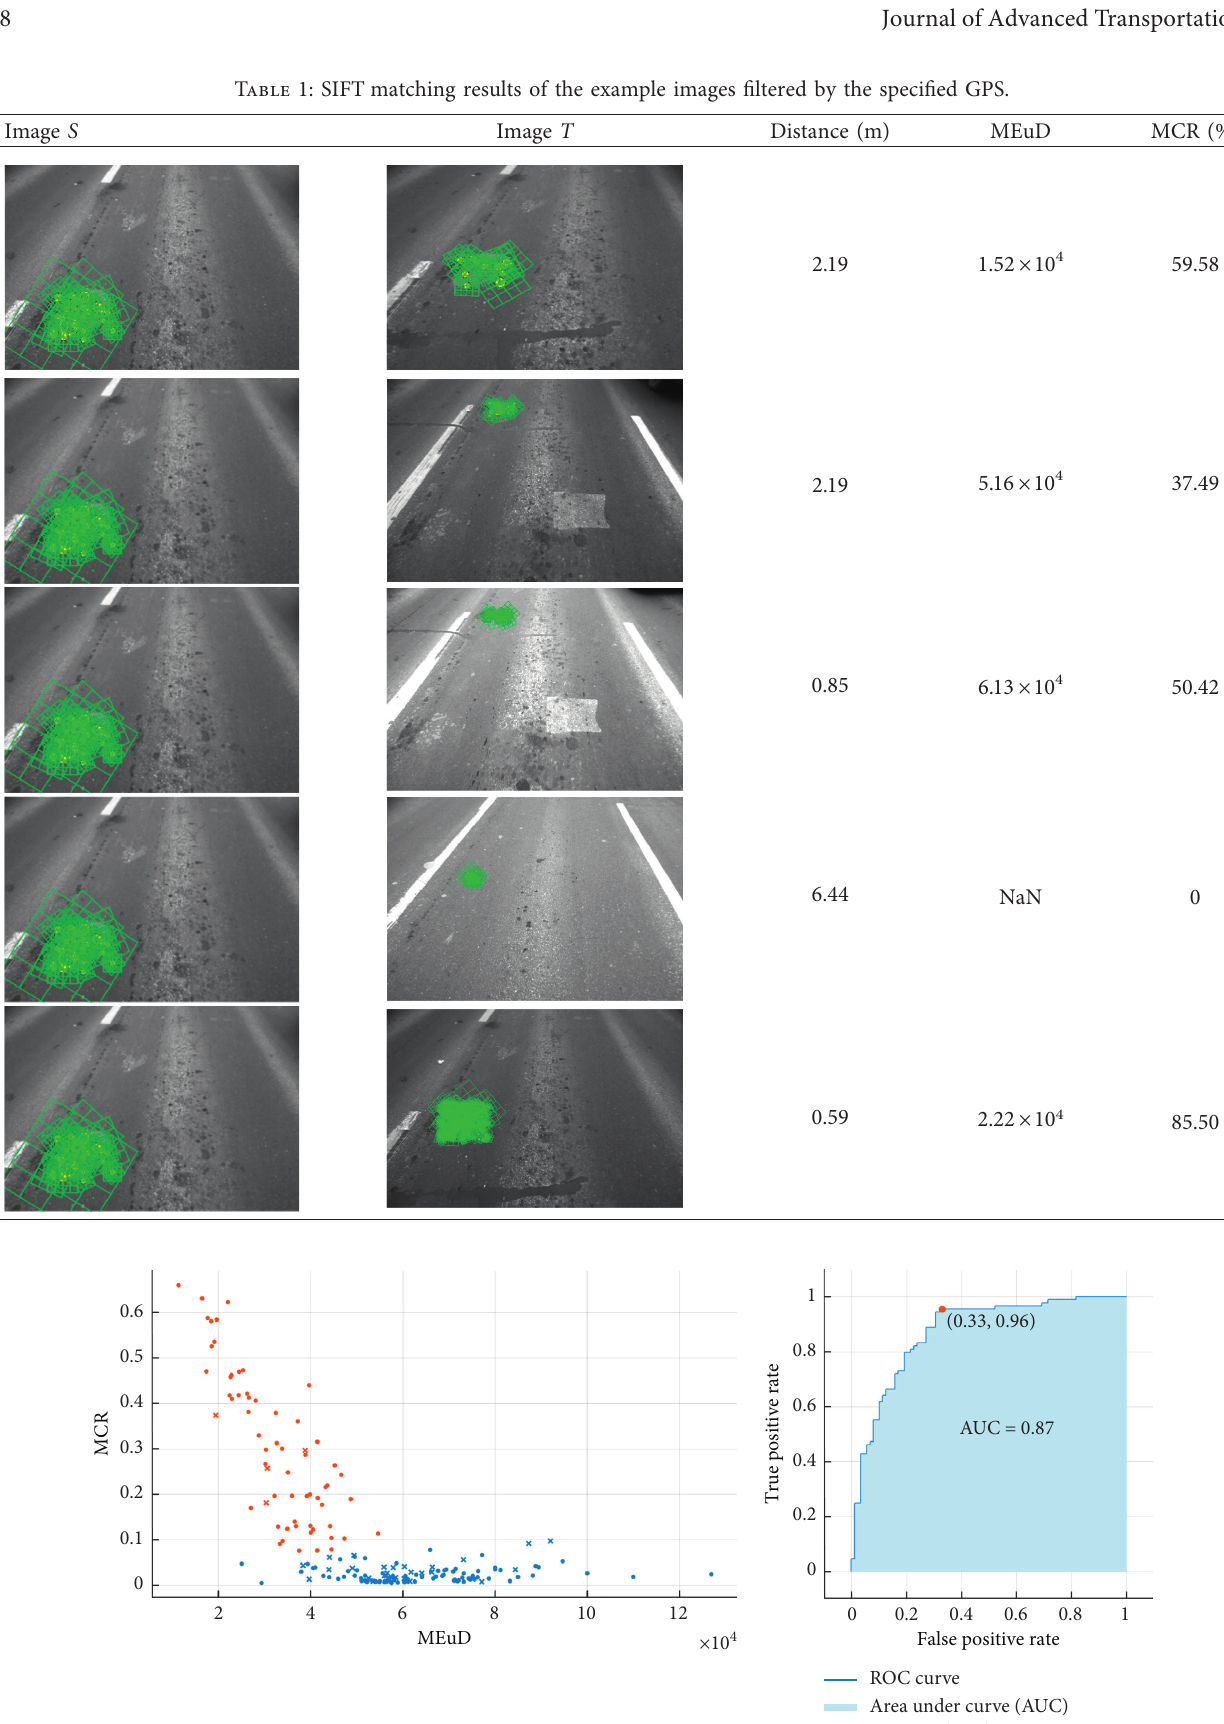
Figure 8: The results of the binary classification based on